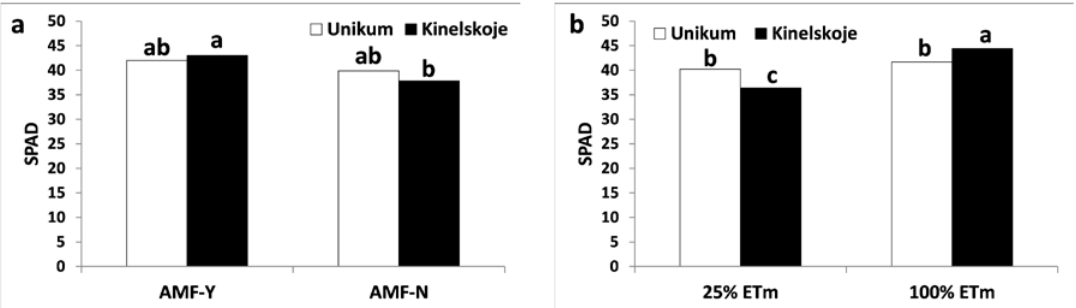
Figure 7. Effect of the studied factors on the SPAD value. ( a ) Genotype X AMF inoculation; ( b ) genotype X ETm restitution. Different letters show statistical differences of the treatments at p < 0.01 (Least Significant Difference—Fisher test). AMF-Y = AMF-inoculated treatment; AMF-N = AMF uninoculated treatment; 25% ETm = restitution of crop evapotranspirated water at 25%; 100% ETm = restitution of crop evapotranspirated water at 100%.